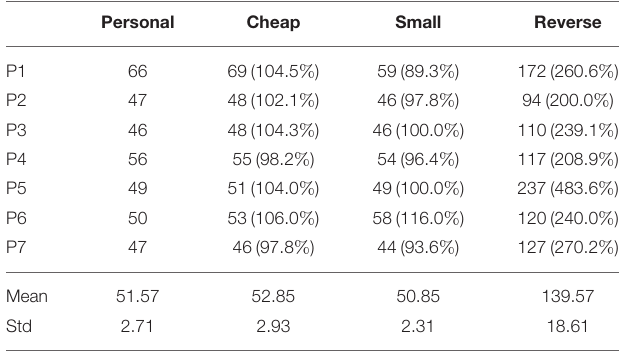
TABLE 2 | Number of errors on reverse violin in first 32 bars of Bach Courante. WS 2S